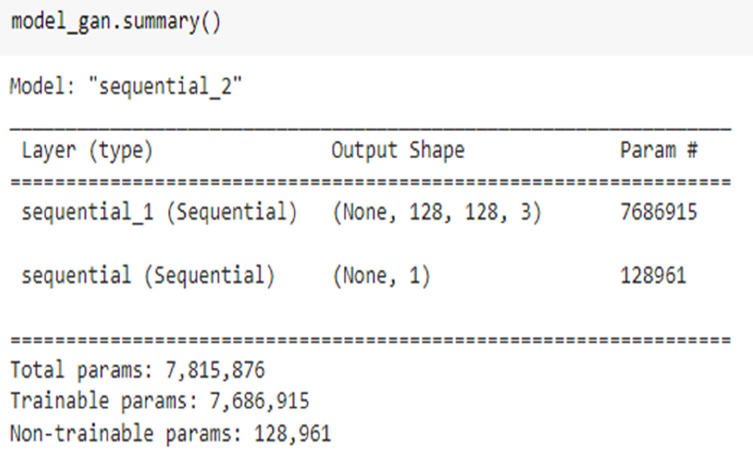
Figure 6. Combined summary for the GAN model.